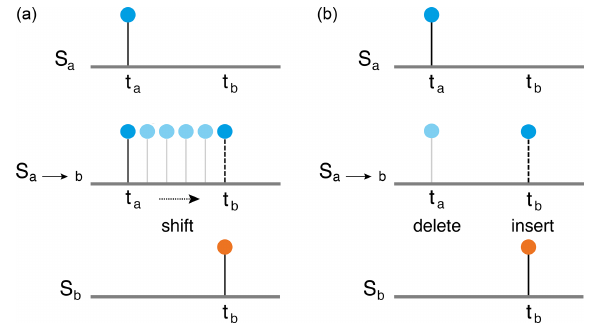
Figure 3. Figures illustrating the operation of shifting (a) and dele- tion/insertion (b)